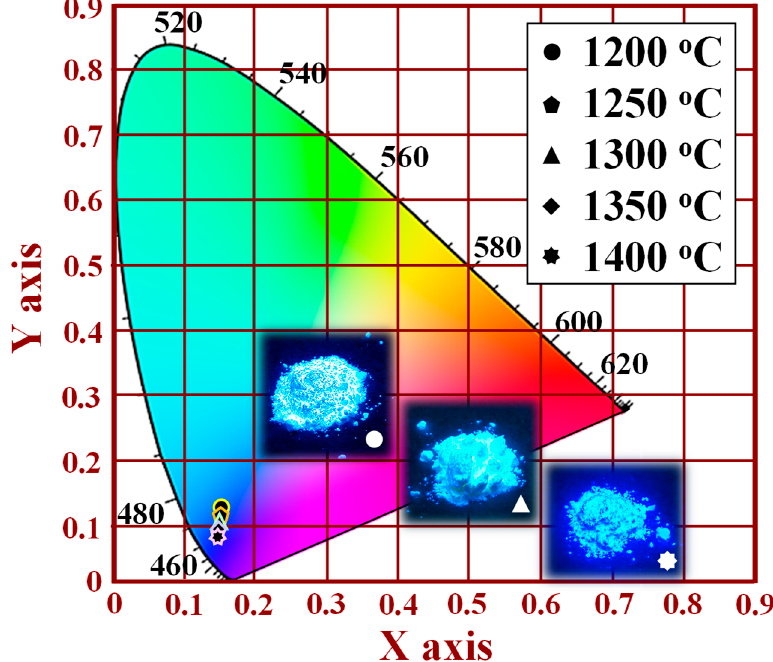
Figure 15. CIE chromaticity diagram for the [Sr 0.99 Eu 0.01 ] 3 MgSi 2 O 8 phosphors sintered at different temperatures.